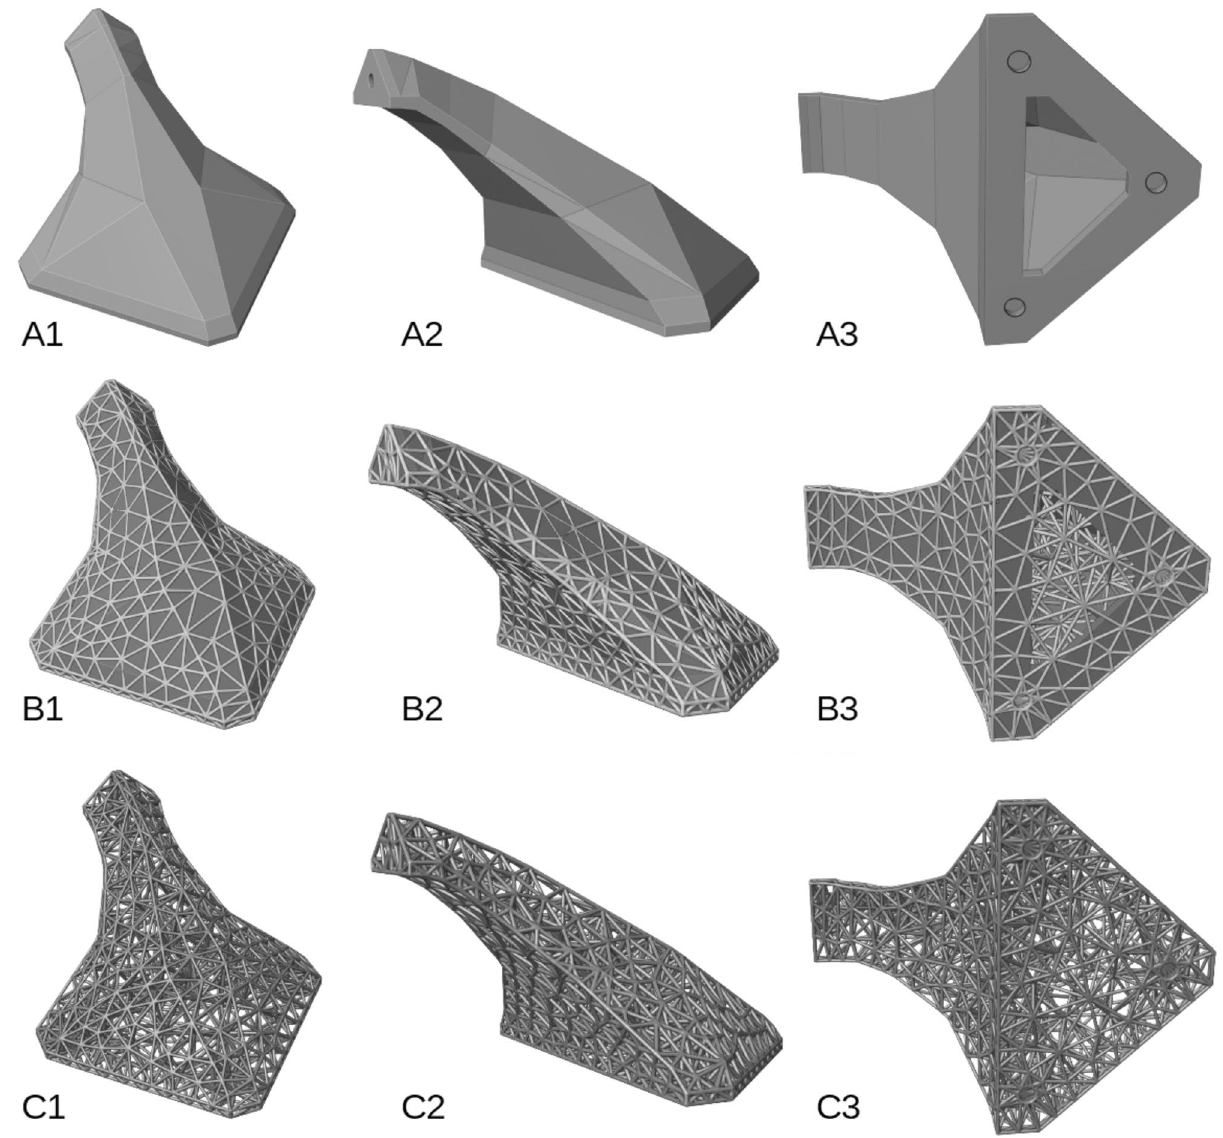
Figure 10. Three views of ( A1–3 ) the original CAD bracket structure ( B1–3 ) the HGon with CAD structure, and ( C1–3 ) the HGon by itself showing the internal meta-structure. Note the tight conformity of the HGon to the original bracket; with edges and mounting holes ( B3 ). There are no ‘hanging’ struts or edges as often the case with lattice-type structures. This high-density HGon has nominal 2.4 mm meta-strut thickness and is 42% lighter (volume reduced) compared to the original CAD solid/shell bracket